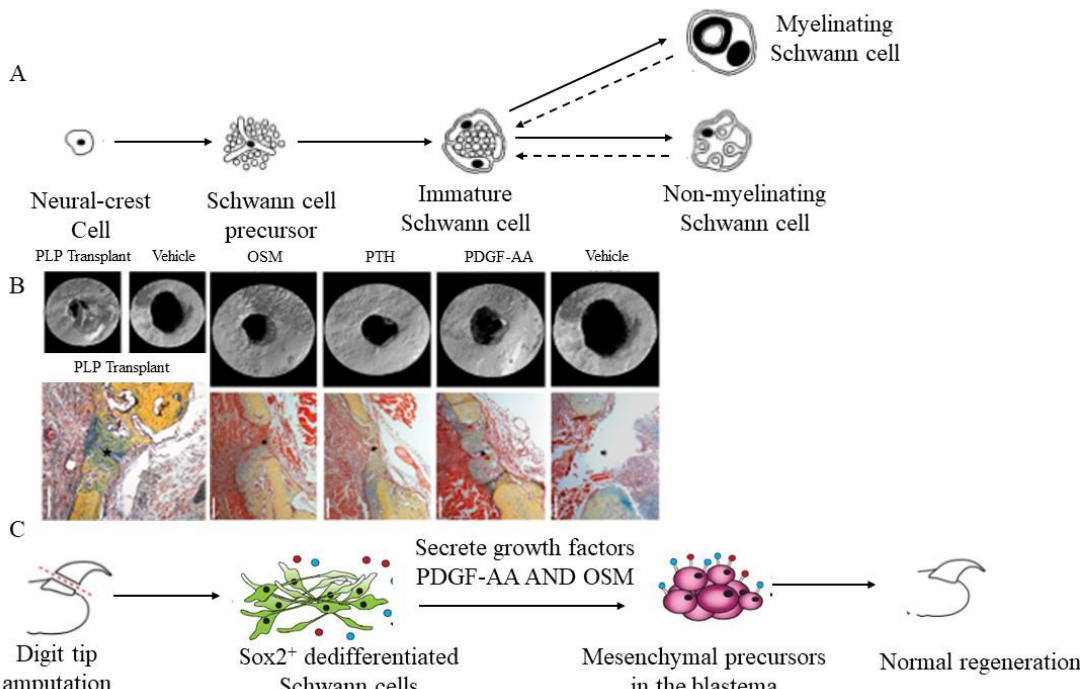
Figure 2. ( A ): The main stages in the development of Schwann cells [138]. ( B ): Schwann cells perform a critical function in bone tissue repair. The mTomato-positive Schwann cells from PLP-treated mandibles formed more bone than the vehicle-treated mandibles [140]. ( C ): Nerve-associated DSCs secrete paracrine substances to help the distal digit of a rat regenerate [142]. Reprinted with permission from Ref. [142]. 2017, Elsevier